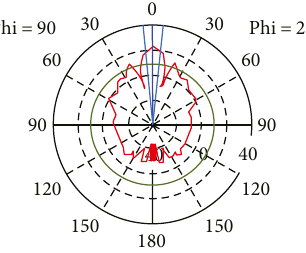
Figure 9: Radiation pattern of the pyramidal horn antenna with the gradient refractive index structure.